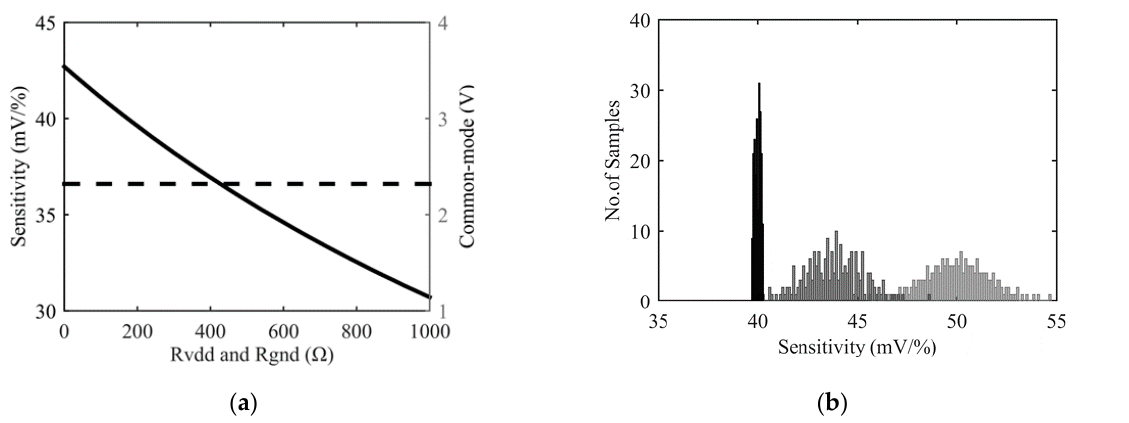
Figure 11. Results after scale factor adjustment: ( a ) variation of sensitivity (continuous line) and common mode voltage (dashed line) with Rgnd and R Vdd , ( b ) Monte Carlo simulation of sensitivity of a bare Wheatstone bridge (light grey), an offset compensated Wheatstone bridge (dark grey) and a fully compensated Wheatstone bridge (in black).